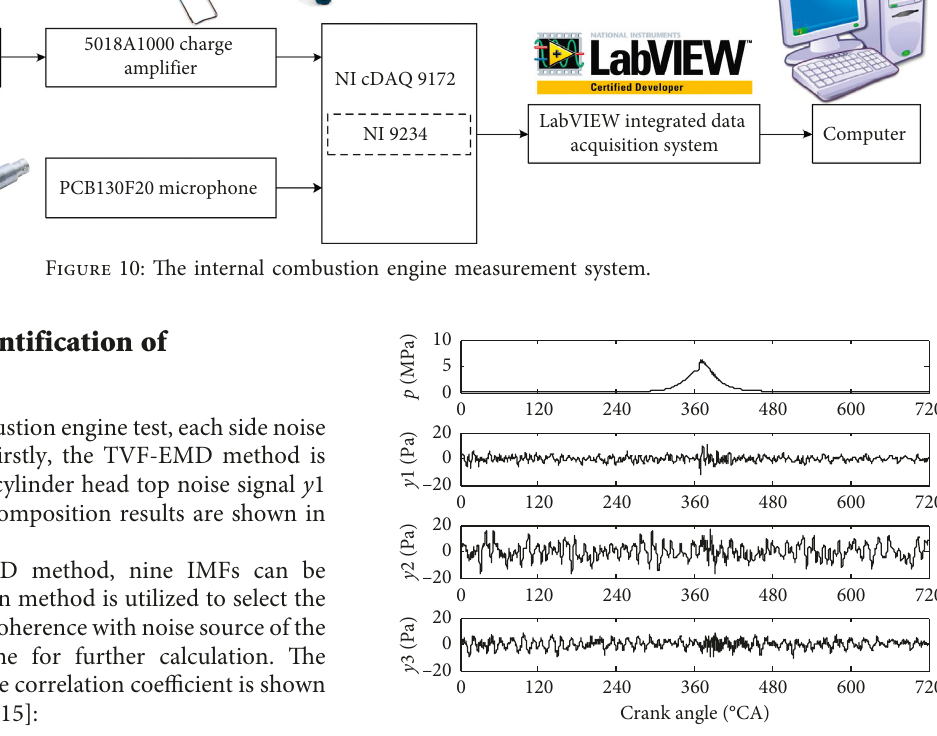
6013CA cylinder pressure sensor